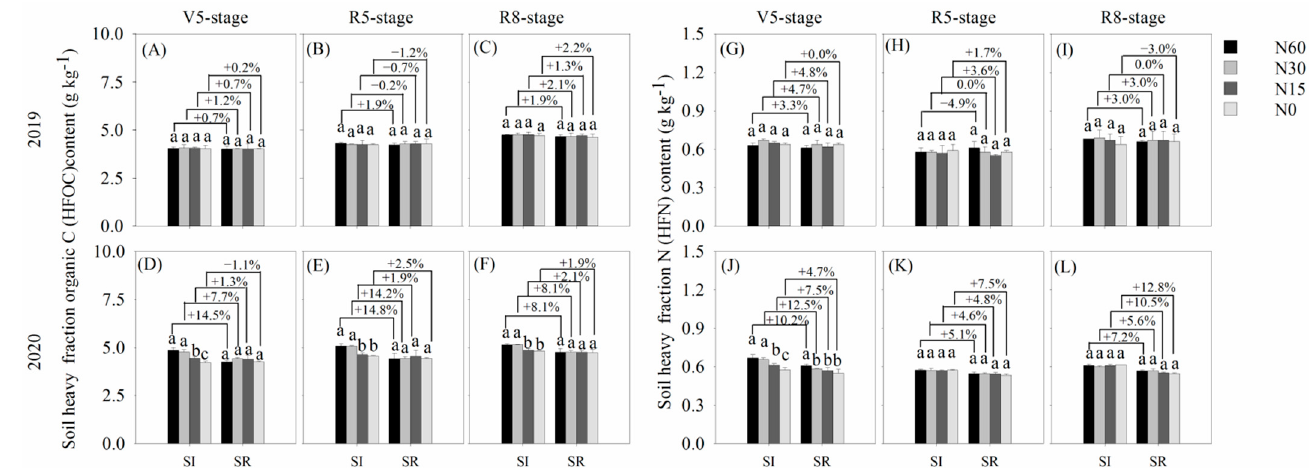
Figure 5. Soil heavy fraction organic carbon and nitrogen content at the different soybean growth stages. ( A ) HFOC content at the V5 stage of soybean in 2019, ( B ) HFOC content at the R5 stage of soybean in 2019, ( C ) HFOC content at the R8 stage of soybean in 2019, ( D ) HFOC content at the V5 stage of soybean in 2020, ( E ) LHFOC content at the R5 stage of soybean in 2020, ( F ) HFOC content at the R8 stage of soybean in 2020, ( G ) HFN content at the V5 stage of soybean in 2019, ( H )HFN content at the R5 stage of soybean in 2019, ( I ) HFN content at the R8 stage of soybean in 2019, ( J ) HFN content at the V5 stage of soybean in 2020, ( K ) HFN content at the R5 stage of soybean in 2020, ( L ) HFN content at the R8 stage of soybean in 2020. In each panel, different lower-case letters “a–c” indicate significant differences under different N application rates within the same straw treatment (LSD, p < 0.05). Same lower-case letters indicate no significant differences under different N application rates within the same straw treatment (LSD, p < 0.05). Data were shown as mean ± S.D. ( n = 3). The values indicate the change in SI relative to SR, and “+” and “ − “ indicate increasing and decreasing, respectively. SI, straw incorporation; SR, straw removal; N60, convention N (60 kg N ha − 1 ); N30, reduced N by 50% (30 kg N ha − 1 ); N15, reduced N by 75% (15 kg N ha − 1 ); N0, zero N (0 kg N ha − 1 ); V5, the fifth trifoliolate stage of soybean; R5, the beginning seed stage of soybean; R8, the full-maturity stage of soybean.